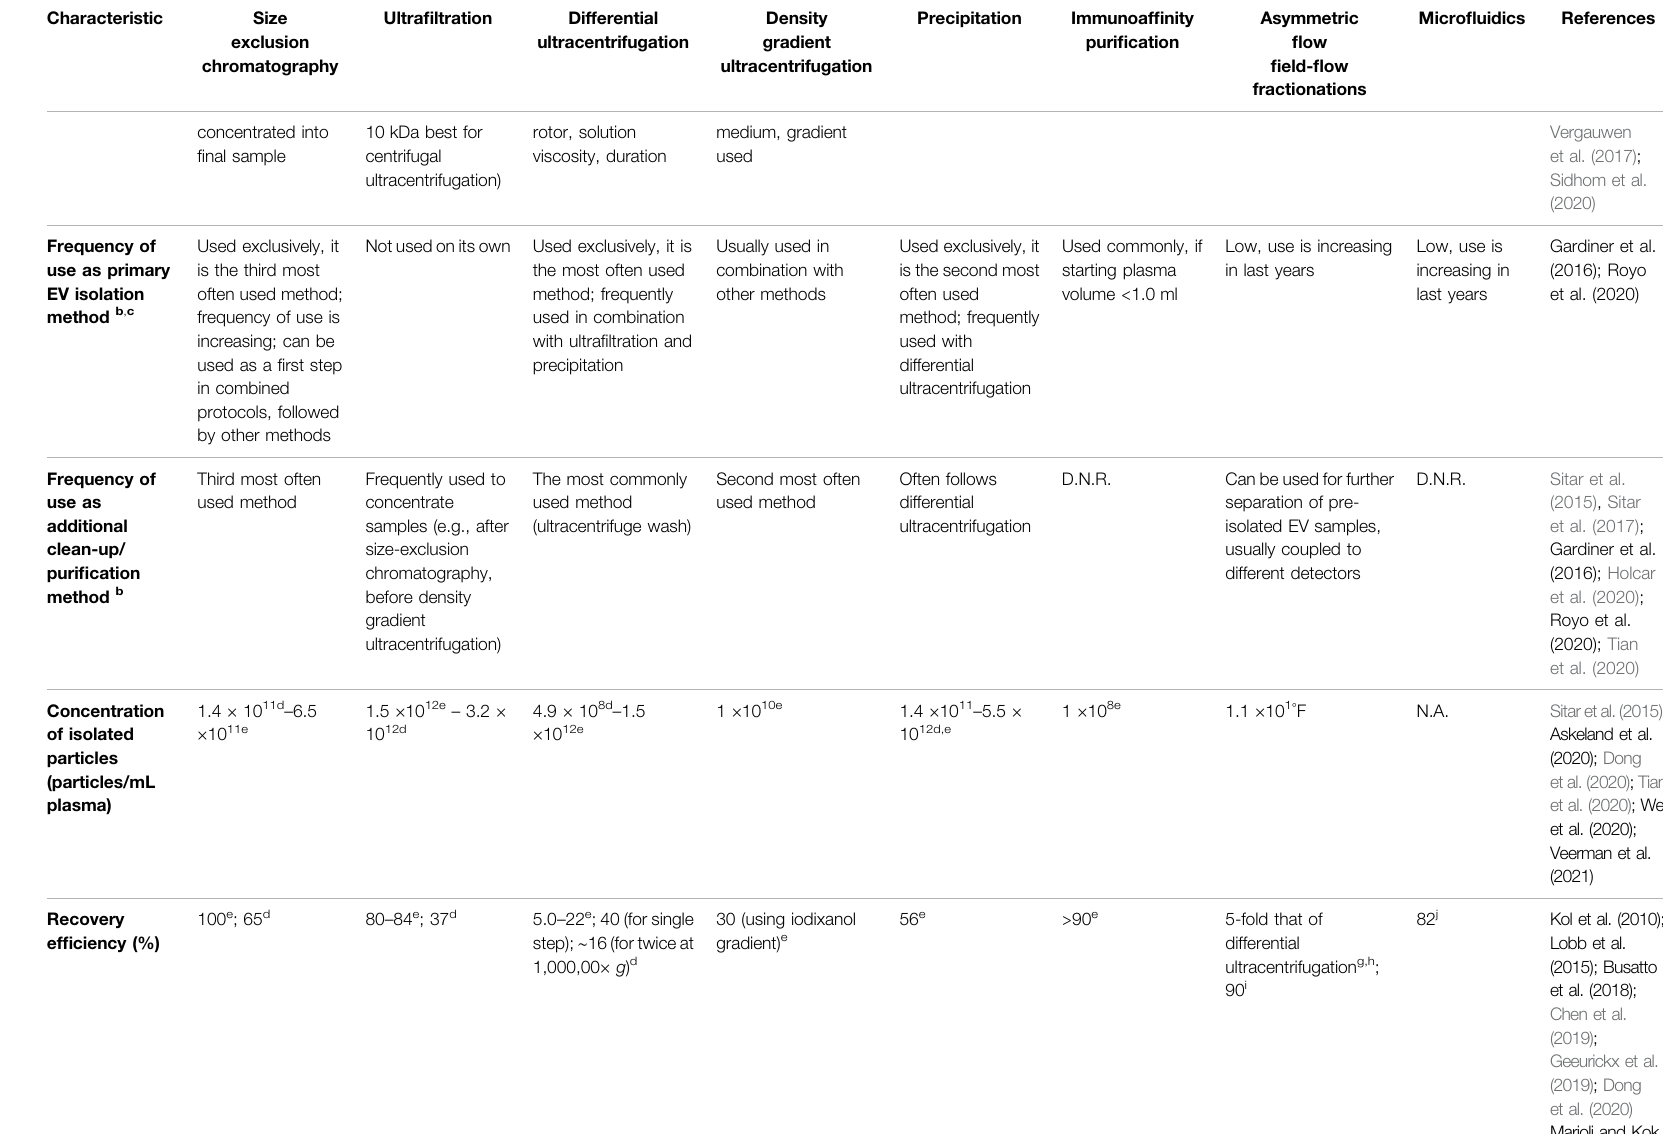
TABLE 2 | ( Continued ) Characteristics of the most commonly used methods for isolation of extracellular vesicles (EVs) from human